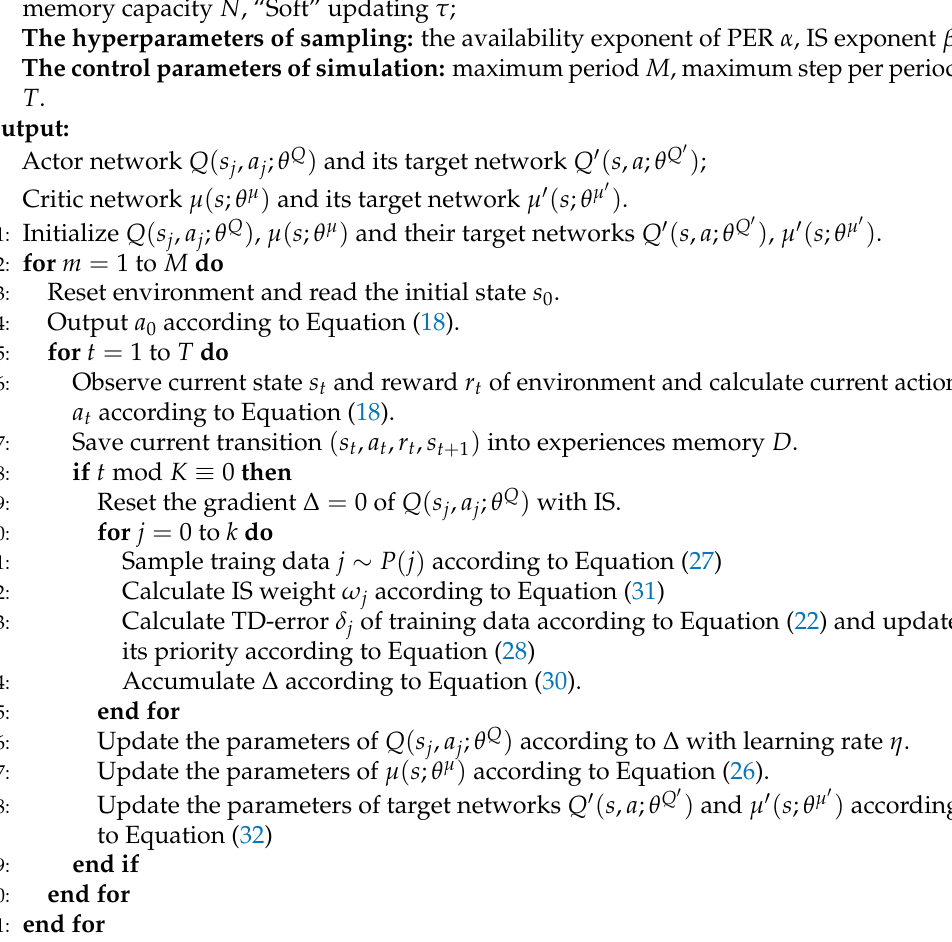
Algorithm 1 The UAV Maneuver Decision-Making Algorithm for Airdrop